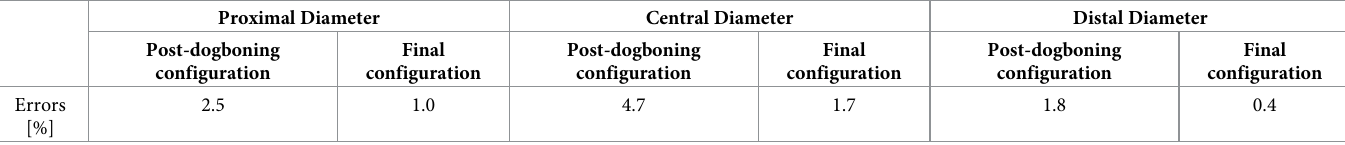
Table 4. Percentage error obtained by comparing the experimental and numerical stent diameters in the “post-dogboning configuration” and the “final configura- tion” of the free expansion test.